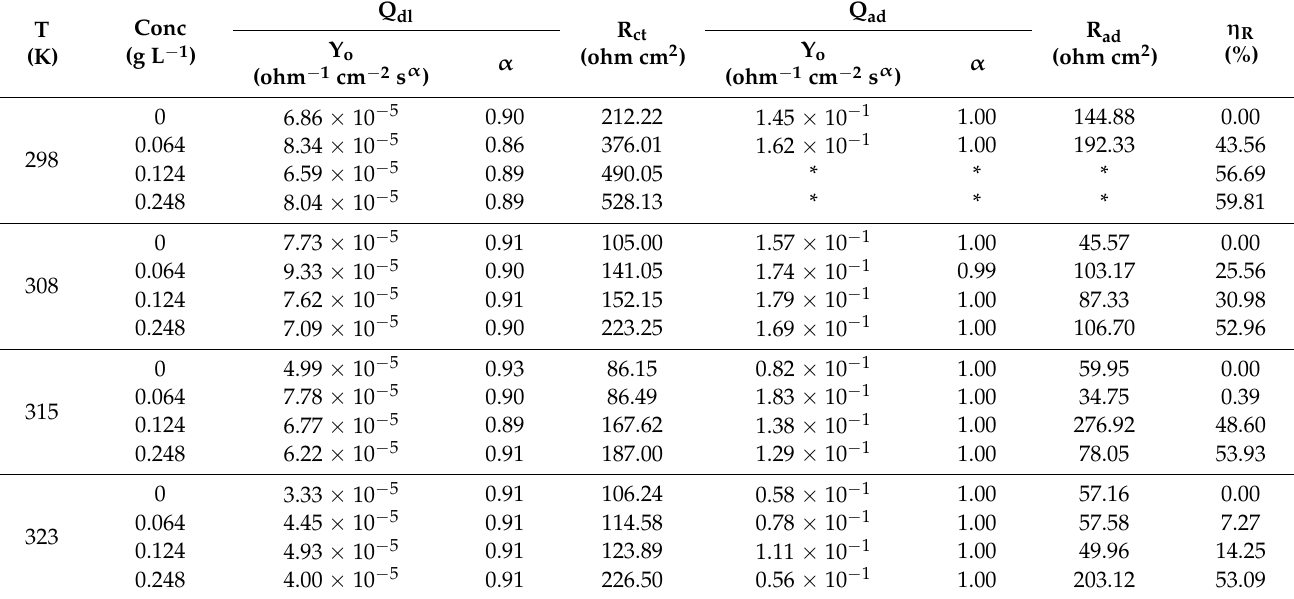
Table 4. Estimates of impedance parameters resulting from a complex non-linear least-squares analy- sis of the experimental impedance spectra and the corresponding inhibition efficiencies of aluminum in 0.1 M HCl in the presence and in the absence of different concentrations of Ilex paraguariensis